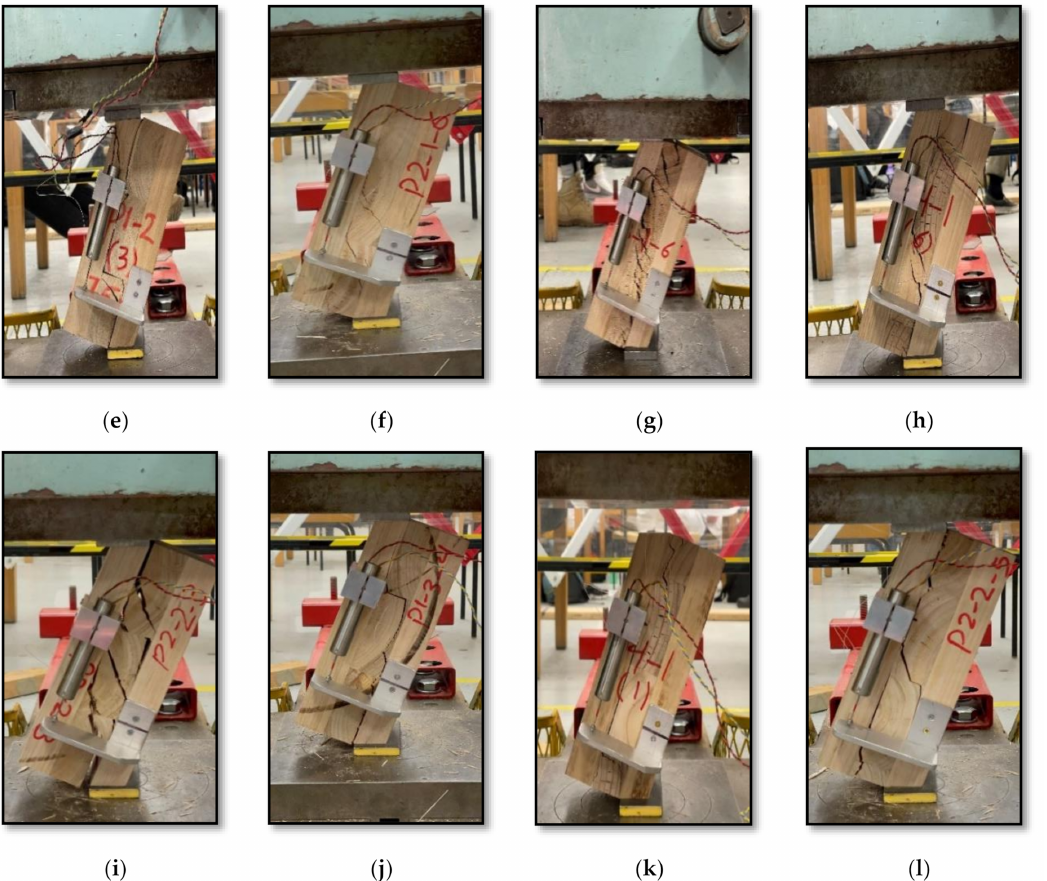
Figure 4. Failure modes of planar shear specimens; ( a – c , e , j ) are RS-MHM;( d , f , i , l ) are RS-MLH; ( g ) is RS-MLM; ( h , k ) are RS-HLH